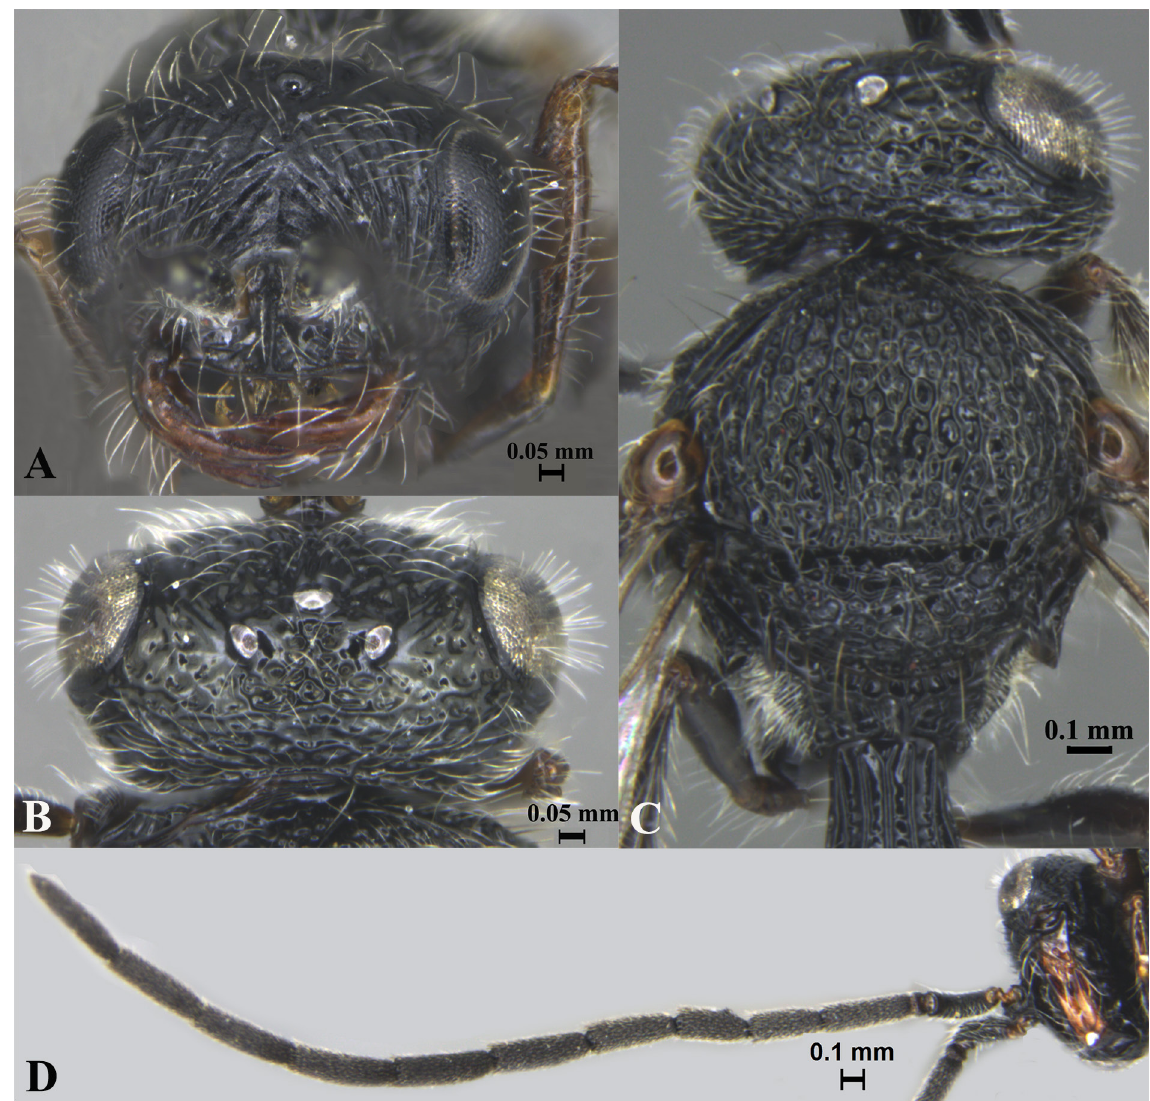
Fig. 26. Odontoscelio sp. 3. ♂ (ICAR-NBAIR P3961). A . Frons. B . Vertex. C . Head and mesonotum. D .